Question: What kind of plot is shown here?
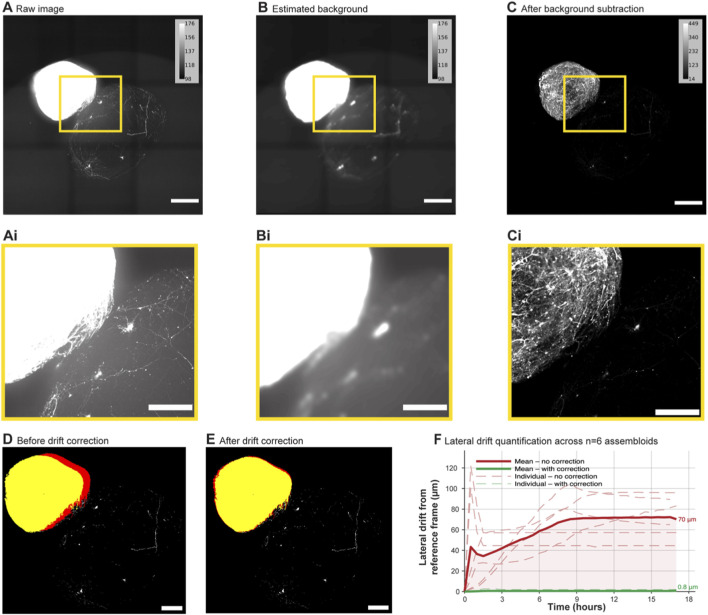
Answer: bar